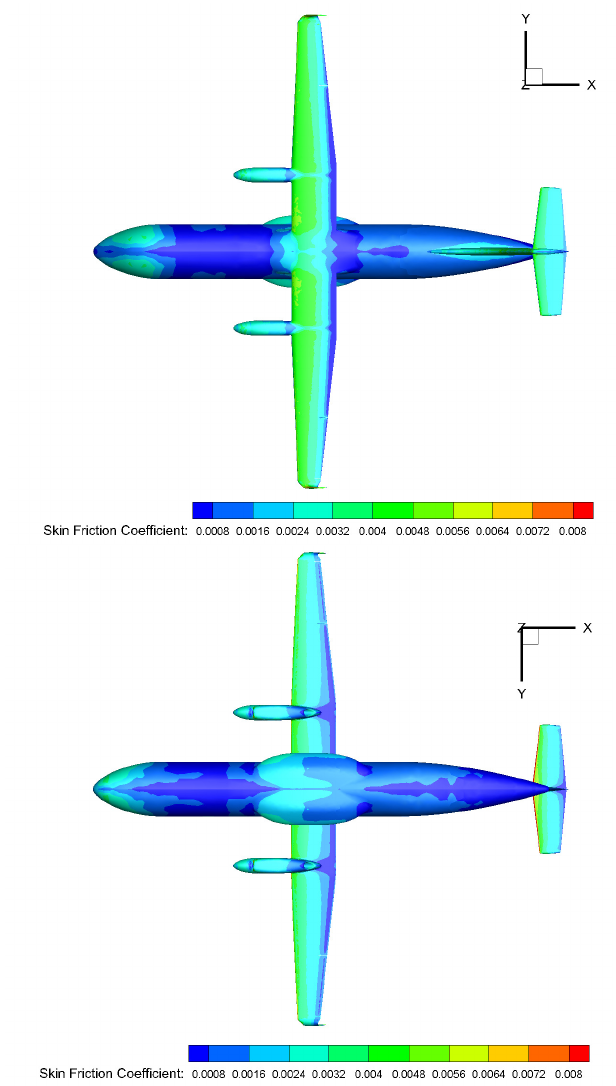
Figure 13. Clean configuration: upper ( top ) and lower ( bottom ) plan views of surface contours for the skin friction coefficient.